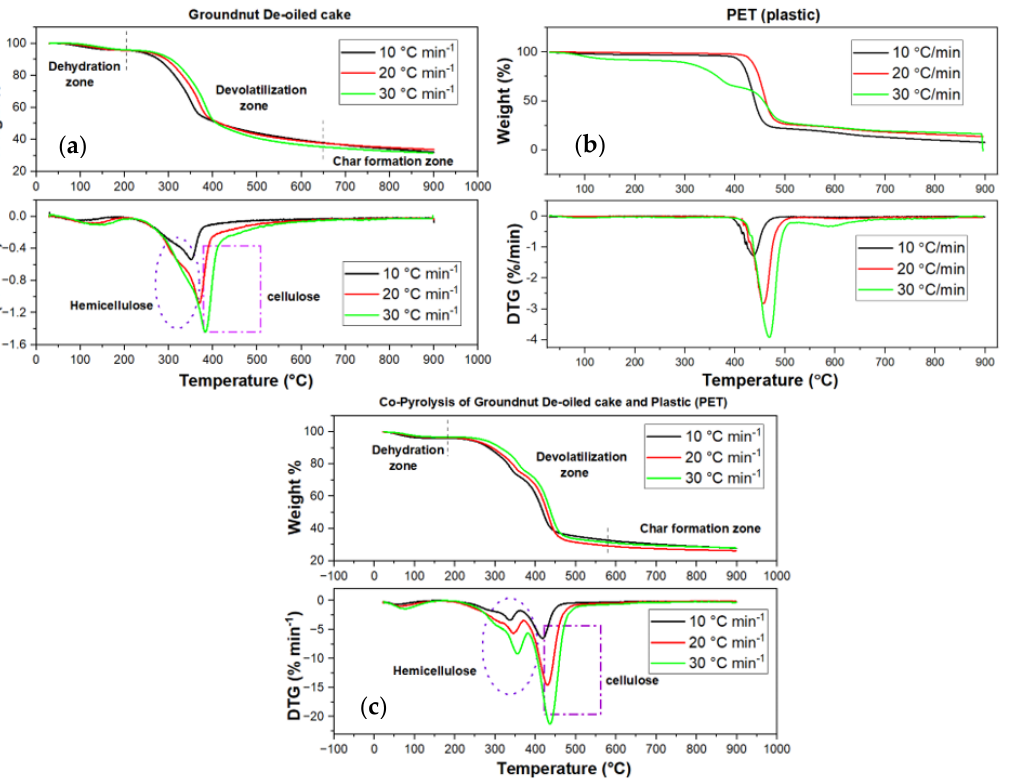
Figure 2. Thermal decomposition behavior of ( a ) Groundnut de-oiled cake (GDC) ( b ) PET plastic and ( c ) Co-feedstock of the GDC and PET (1:1).